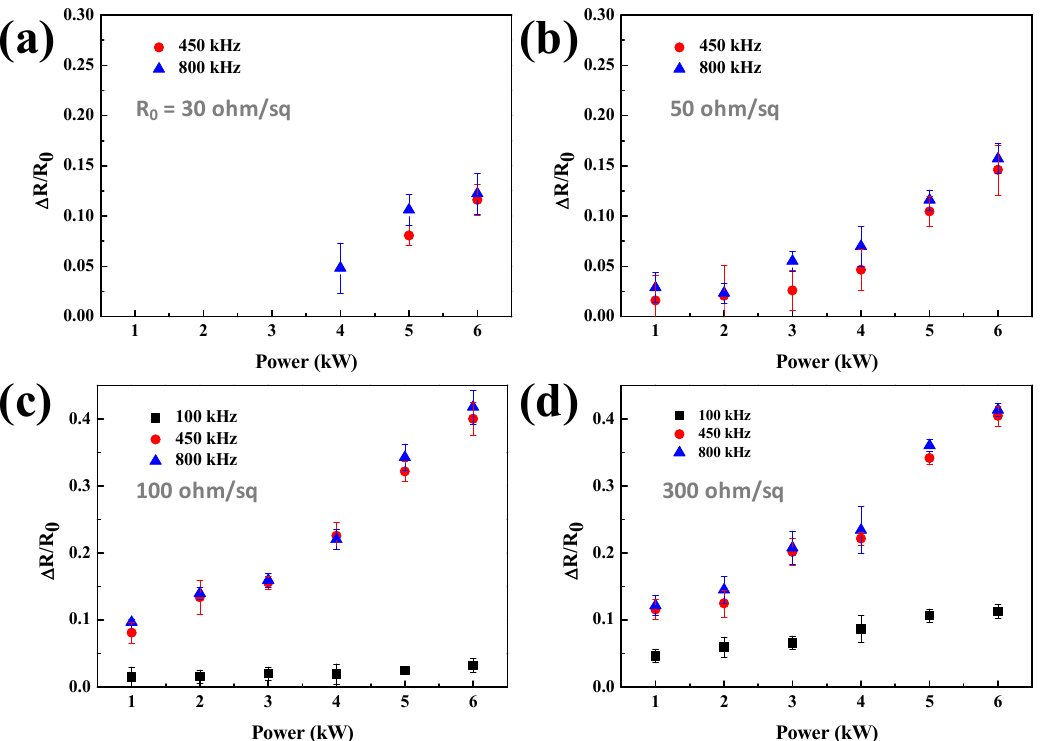
Figure 2. Change of Ag NWs sheet resistance by the welding with different frequencies of 100, 450, and 800 kHz and with 1–6 kW power for 60 s for the Ag NW networks with the initial sheet resistances of ( a ) 30, ( b ) 50, ( c ) 100, and ( d ) 300 ohm/sq.